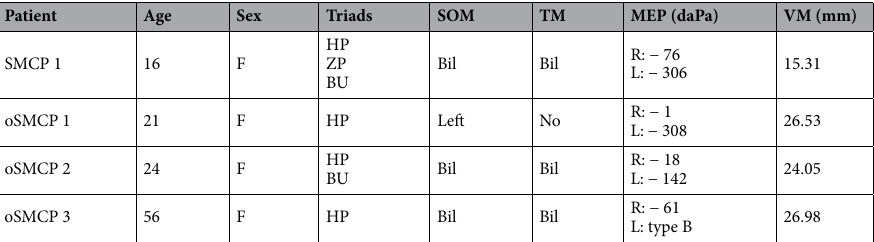
Table 2. Detailed characteristics of patients with submucosal cleft palate. Triads Calnan triads, SOM history of recurrent serous otitis media, TM tympanic membrane retraction, MEP middle ear pressure, VM